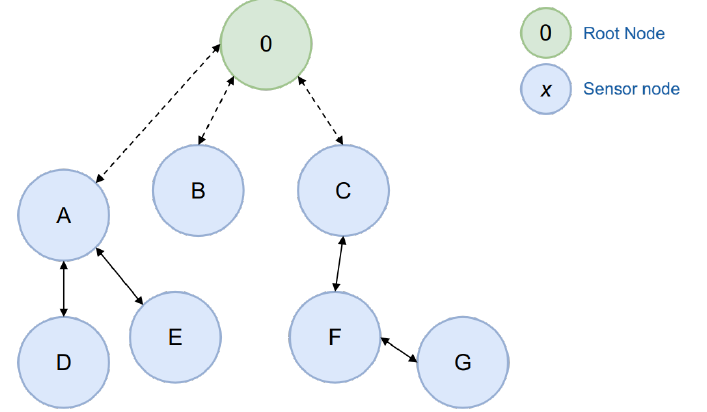
Figure 3. Concept diagram of DODAG node